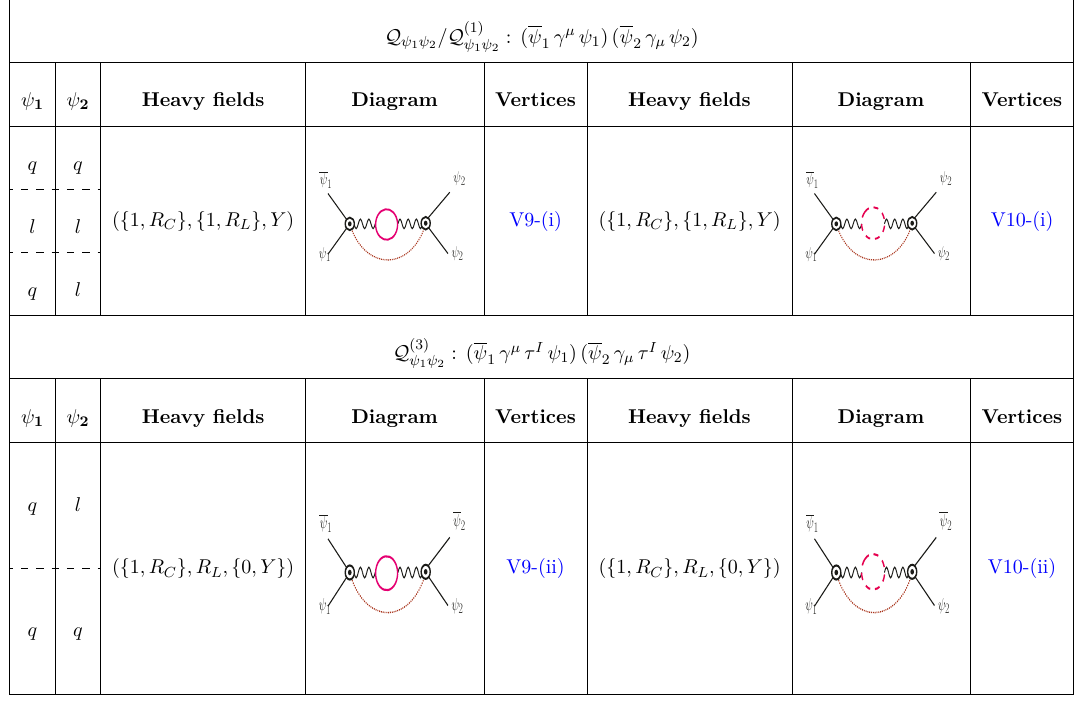
Table 12 . Heavy field representations that are obtained by unfolding the ψ 4 operators, composed of the left chiral SM fermions q and l , into non-trivial one-loop-level diagrams and the corresponding vertices. In each sub-table, operators with different fermions as external legs but leading to identical heavy field representations through similar diagrams have been grouped together. The headers schematically describe the covariant forms of the